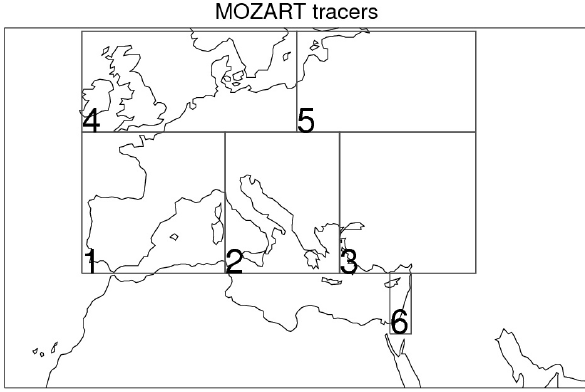
Fig. 4. Spatially tagged CO regions (both anthropogenic and BB) that were used for tracing transport in MOZART. The partitioning is based on previously known transport patterns and the emission